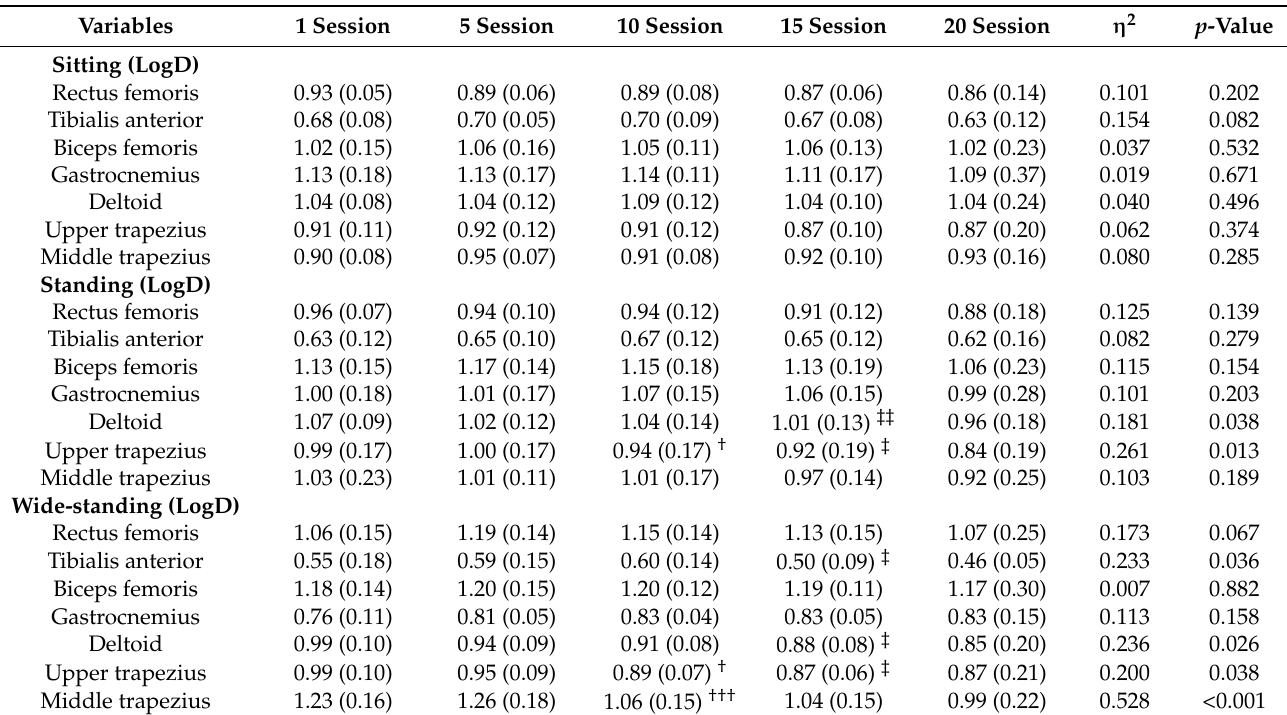
Table A5. Muscle elasticity during the locomotion training